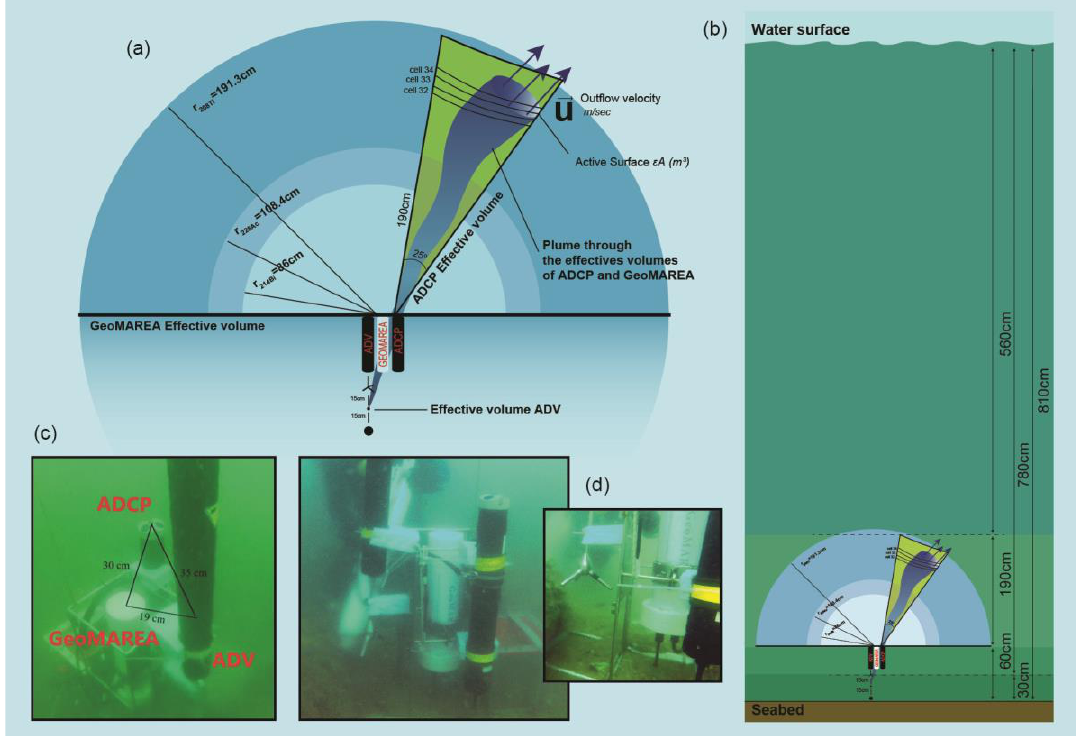
Figure 2. A schematic drawing of the experimental setup of the sensors’ deployments. The experi- mental station ( c ) and sensors’ setup on the flow ( d ). The effective radii (r eff ) of the measurement geometry of the GeoMAREA system are also indicated ( a ). The geometry of sensors’ setup effective volume are also depicted including the water surface level ( b ).